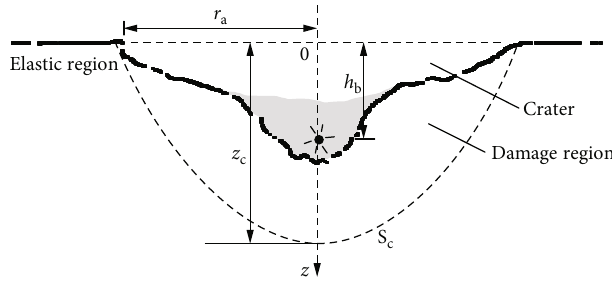
Figure 2: Diagram of the damage region in a shallow-buried